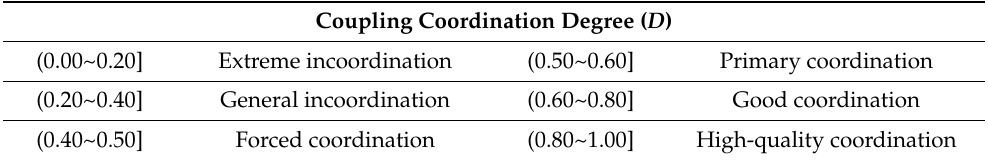
Table 3. Criteria for classifying the coupling coordination degree.